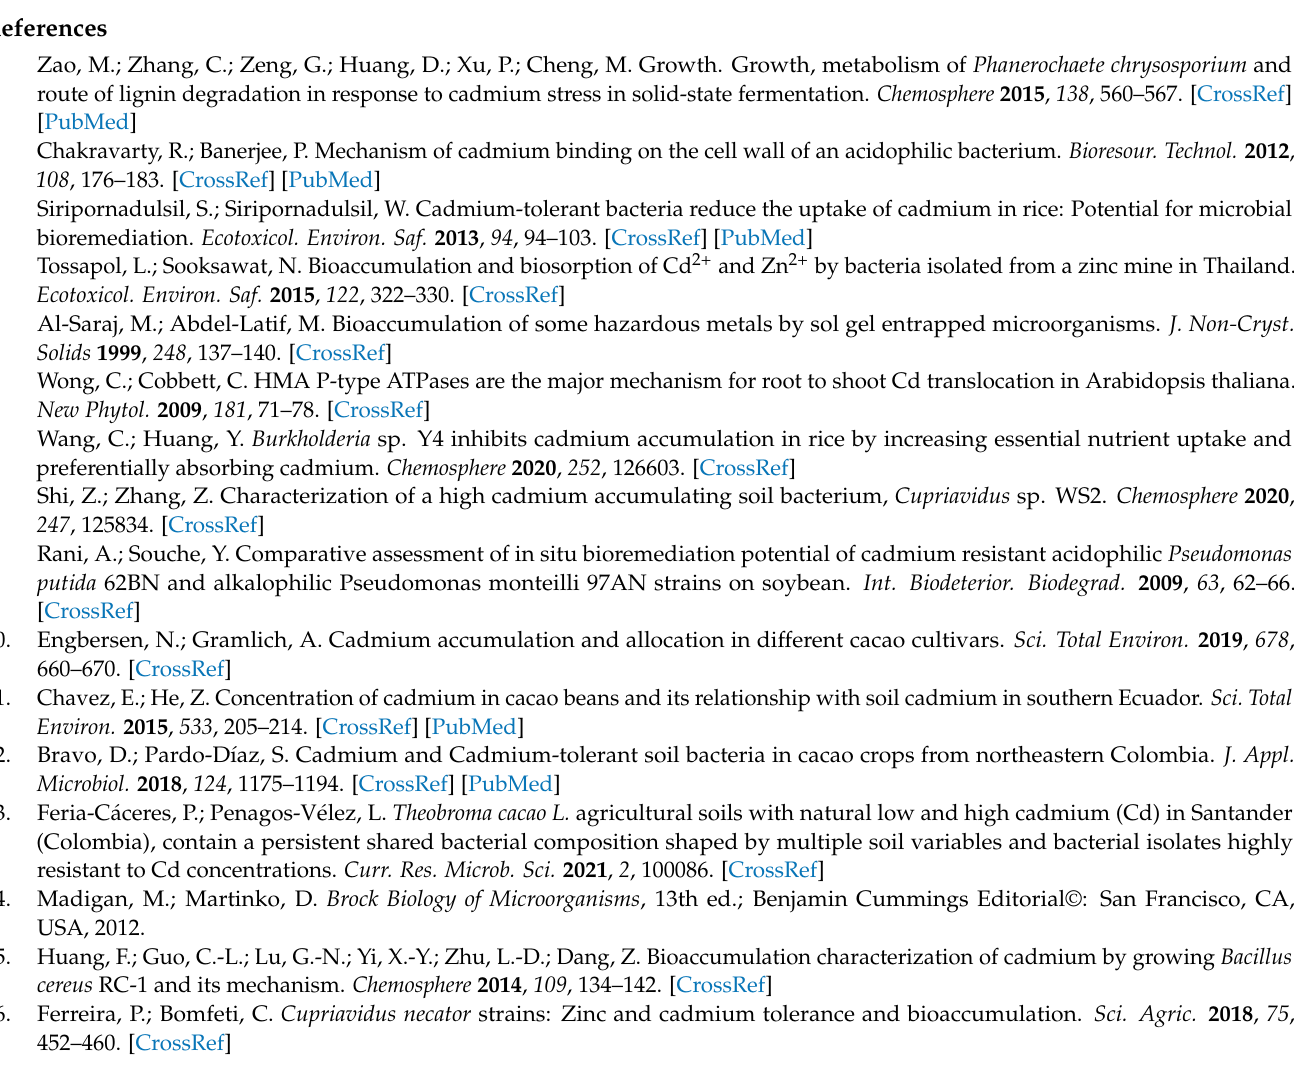
Figure S2: EDX spectra in some strains; Figure S3: FT-IR